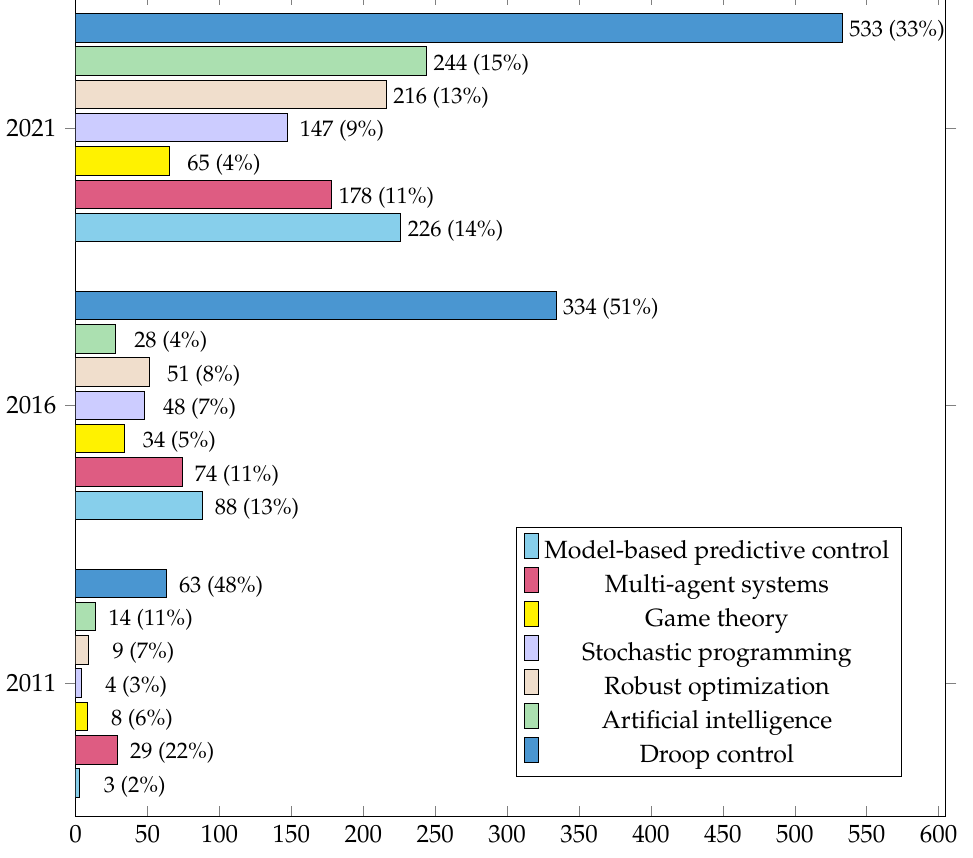
Figure 2. The methods used for MG/NMG management with a focus on years 2011, 2016 and 2021. The research papers considered here—these papers deal with different aspects of MG/NMG management—are published in peer-reviewed journals owned by the leading publishers of scientific